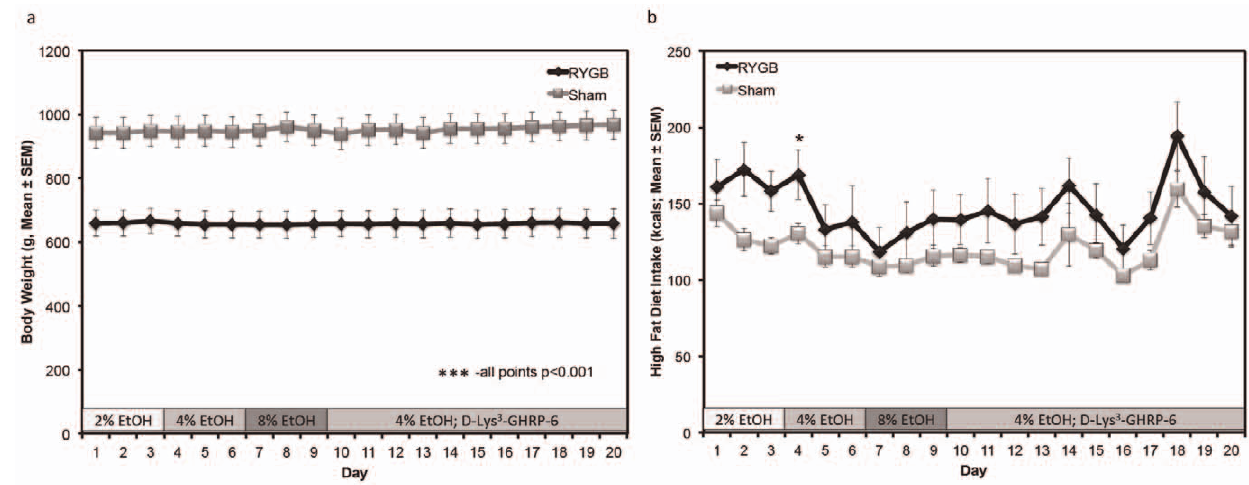
Figure 1. RYGB and Sham rats differed significantly in body weight after bypass or sham surgeries, but not high fat diet intake. a) Daily body weights (in grams) of RYGB and Sham rats beginning 4 weeks after the Roux-en-Y gastric bypass or Sham surgical procedures were averaged and are presented as Mean 6 SEM. Throughout the alcohol testing period, RYGB rats (black diamonds) had significantly lower body weights on each day of testing. *** p , 0.001, all days. b) Daily intake of high fat diet (in grams) by RYGB and Sham rats throughout the alcohol testing period is presented as Mean 6 SEM. Throughout the majority of the testing period there was no significant difference in intake; RYGB rats (black diamonds). * p , 0.05.